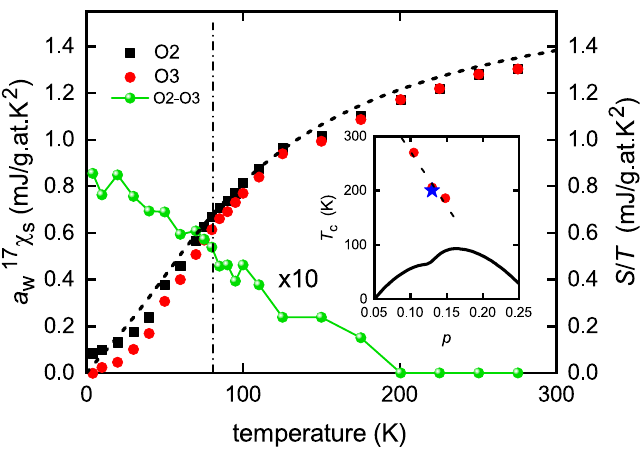
Figure 2. Dashed curve: the normal-state entropy coefficient, S n ( T )/ T , obtained by integrating the dashed curve for γ n ( T ) in Fig. 1b. Red and black data points: the spin susceptibility, χ s ( T ) , calculated from the planar oxygen Knight shifts 17 K 2, c and 17 K 3, c associated with the O2 and O3 oxygen sites. χ s ( T ) is expressed in entropy units by multiplying by the Wilson ratio, a W , for weakly interacting Fermions. The green connected data points 17 K are the difference in O2 and O3 spin susceptibilities obtained from 17 K 2, c 3, c , showing the abrupt onset of − nematic splitting at 200 K within the pseudogap state. The inset shows the cuprate phase diagram with the three red data points of Sato et al. 10 marking the onset of nematicity in Y123. The blue star marks the onset of nematic splitting of the O2 and O3 Knight shifts in